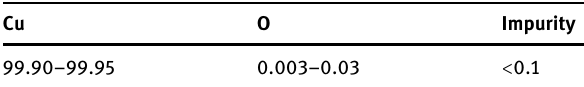
Table 1: Chemical composition of copper ( wt% )